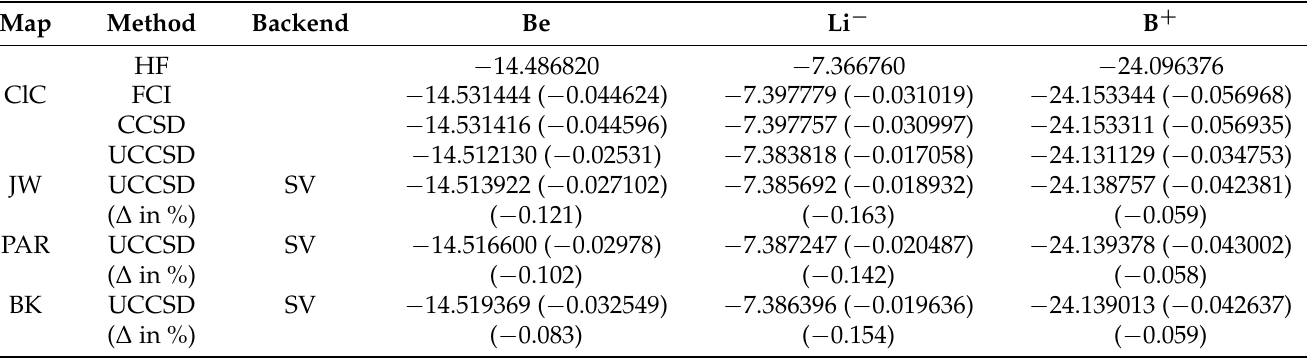
Table 3. The table presents the energies for Be, Li − , and B + in the 3-21G basis. The same notations as in Table 1 are adopted here.